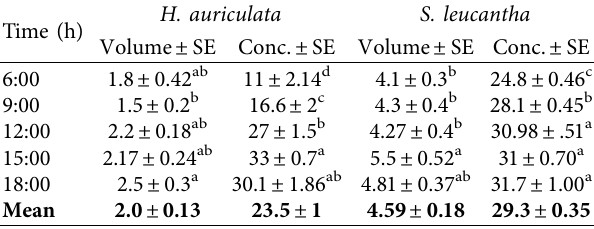
Table 2: Mean nectar concentration (%) and volume ( μ l) per fower at 3 hours intervals with ± (SE) of the 2 species at 6:00–18:00 hours in southwest Shewa